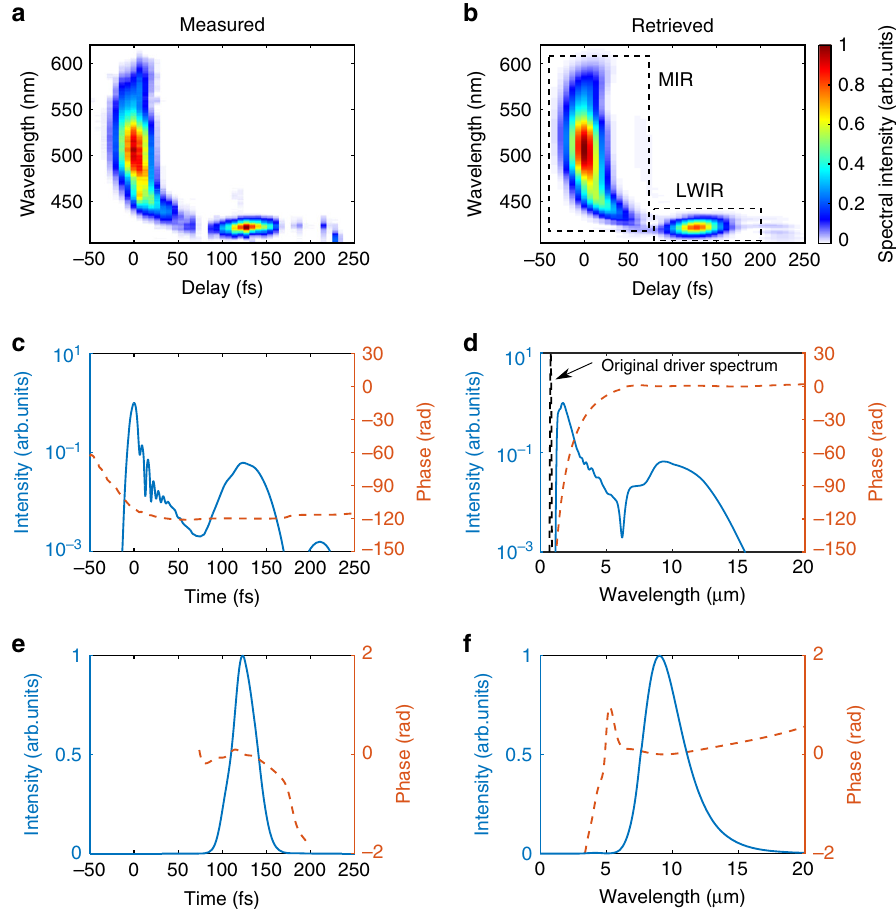
Fig. 2 Retrieval of the XFROG trace. a , b Measured and retrieved XFROG traces. The two dashed boxes in ( b ) are the FWDFG signals generated by MIR (1.5 – 6 μ m) and LWIR (6 – 20 μ m) components, respectively. c , d Retrieved IR temporal and spectral intensity and phase. The intensities are shown on a logarithmic scale. The dashed black line in ( d ) shows the original spectrum of the 810 nm drive laser. e , f Retrieved LWIR temporal and spectral intensity and phase. The gentle quadratic phase variation shown in ( e ) and ( f ) is consistent with a small linear chirp seen in ( a